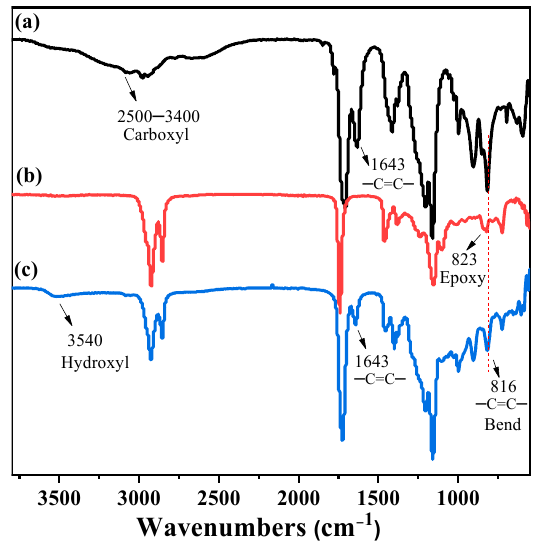
Figure 1. FT-IR spectra of ( a ) MAAMA, ( b ) ESO, and ( c ) MMESO.